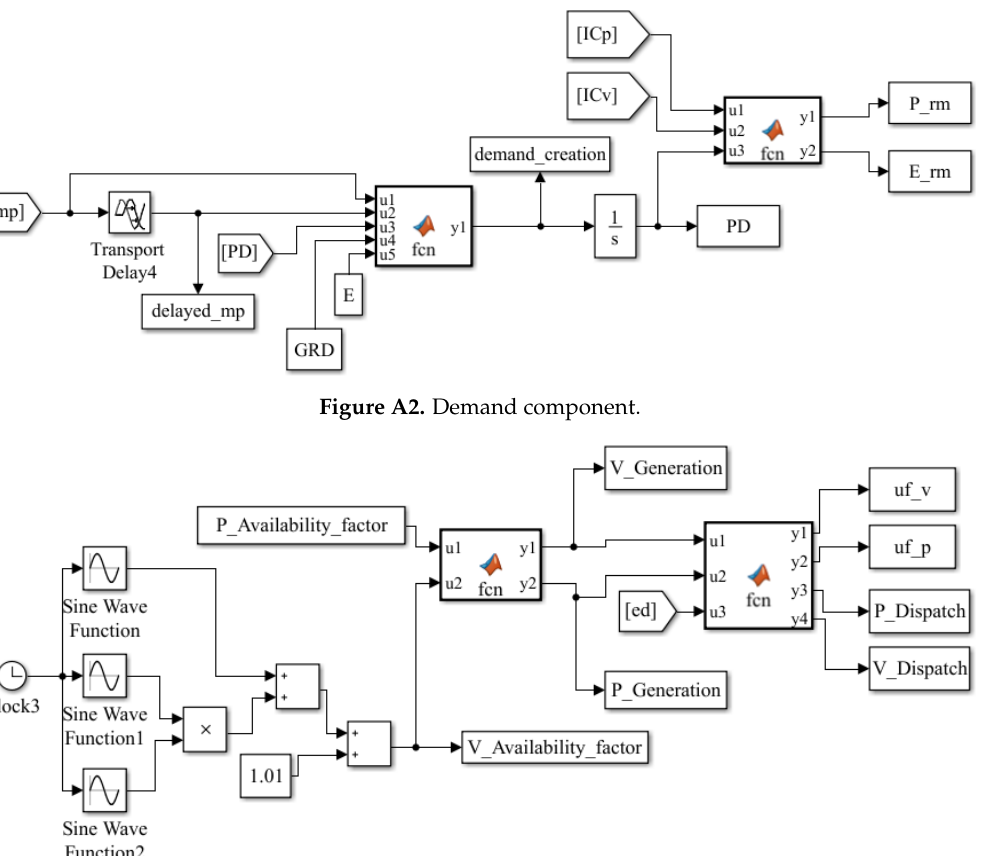
Figure A1. Supply side from (P) and (V) generation.